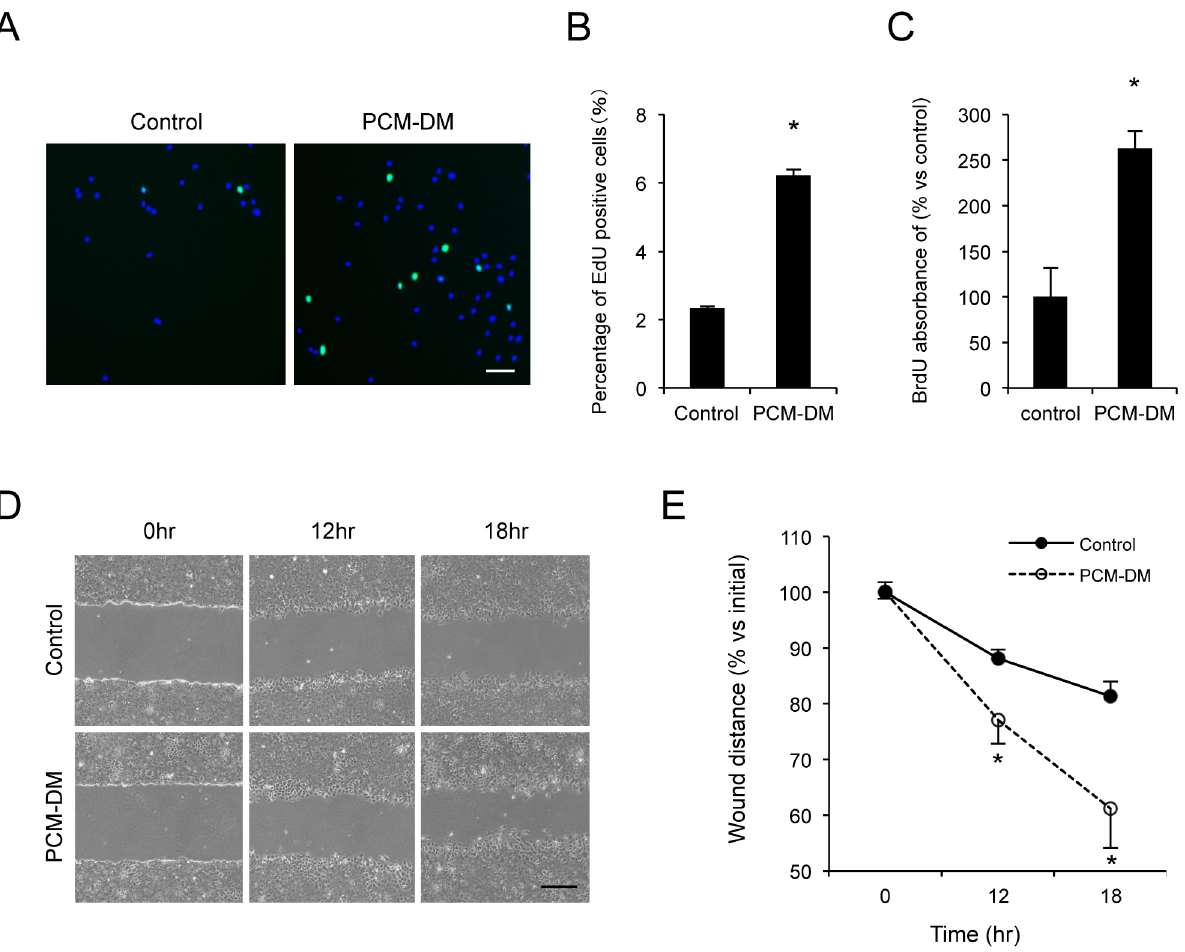
Figure 3. Effect of PCM-DM on the promotion of cell proliferation and migration. (A + B) To test the proliferative potential, the MCECs cultured on the PCM-DM were immunostained with 5-ethynyl-2 Click-iT H EdU Imaging Kits, and the percentages of EdU-positive cells were evaluated after 24 h of incubating with 10 m M EdU. The experiments were performed in duplicate. Scale bar: 100 m m; * p , 0.01. (C) The MCECs were seeded at a density of 5.0 6 10 3 cells/well. The proliferation of the MCECs was evaluated by a BrdU incorporation assay after 24 h of incubating with 10 m M BrdU. The experiment was performed in duplicate. * p , 0.01. (D + E) The MCECs were cultured for 14 days after reaching confluence, and the monolayer cells were wounded by scratching. After 12 and 18 h, the wound distance was quantified by Image J software ( n =10). The experiment was performed in triplicated. * p , 0.01; scale bar: 200 m m.